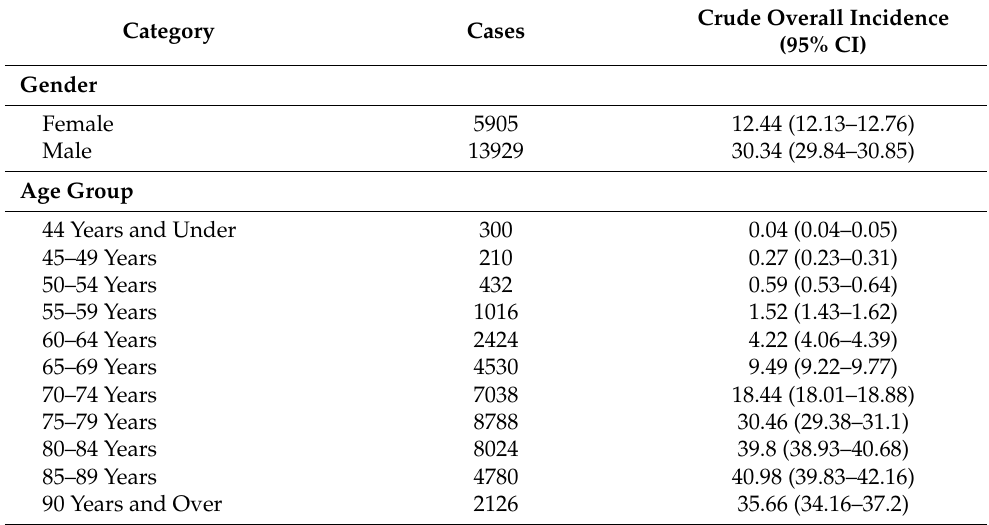
Table 2. Crude estimated incidence of AAAs/100,000 person-years using NZ census statistics stratified by gender and